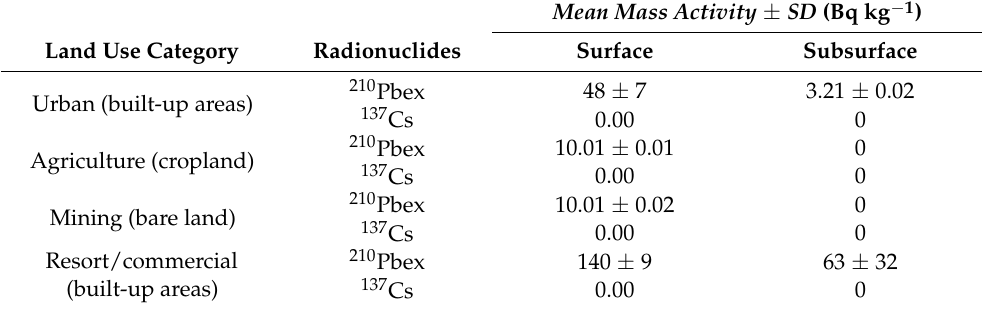
Table 5. Activity concentrations (mean) of 210 Pb ex and 137 Cs in the surface and subsurface samples from the different land use